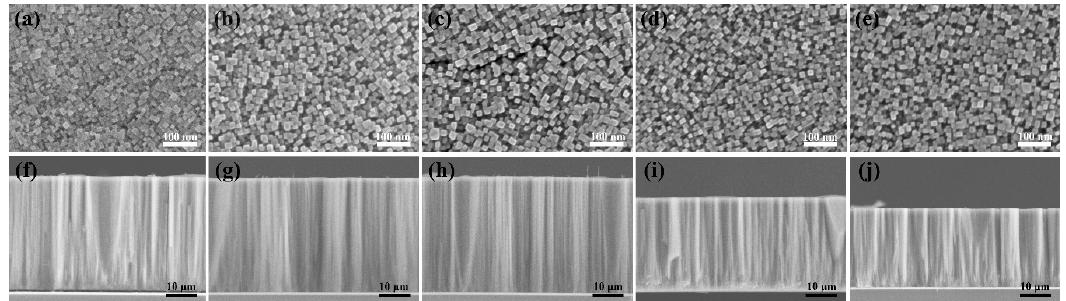
Figure 4. Morphological characterizations of pure TiO 2 NWAs (TS0) and Sn-doped TiO 2 NWAs (TS1, TS2, TS3, TS4): ( a – e ) top-surface field emission scanning electron microscopy (FESEM) image of TS0, TS1, TS2, TS3, TS4, respectively; and ( f – j ) cross-sectional FESEM image of TS0, TS1, TS2, TS3, TS4, respectively.